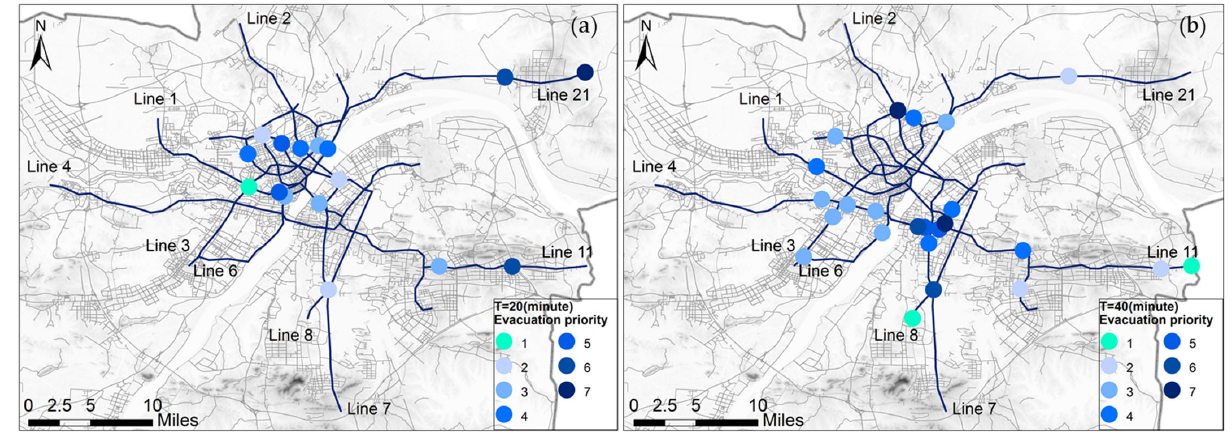
Figure 20. Evacuation nodes at T = 20 min ( a ) and T = 40 min ( b ).